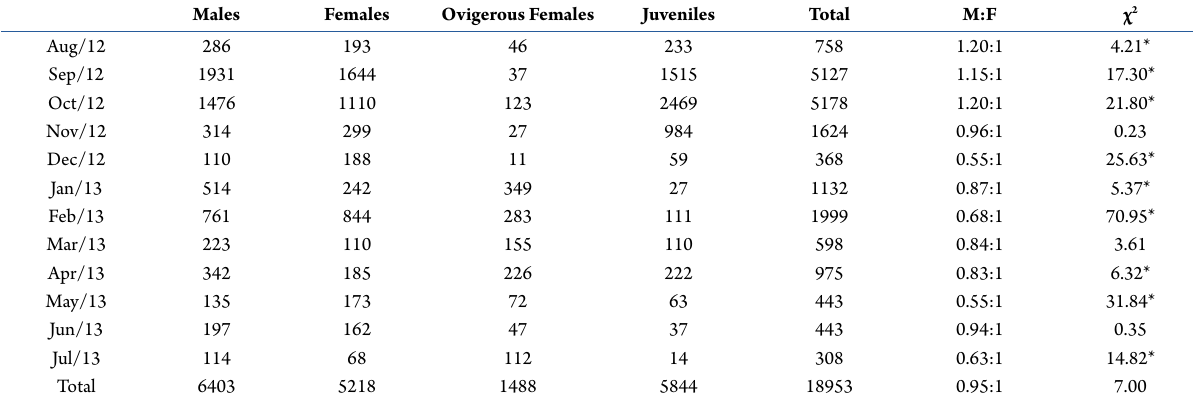
Table 2. Number of specimens sampled monthly for a year, monthly sex ratio and goodness of fit analysis ( χ ²) of Hyalella gauchensis , Palmeira das Missões, state of Rio Grande do Sul